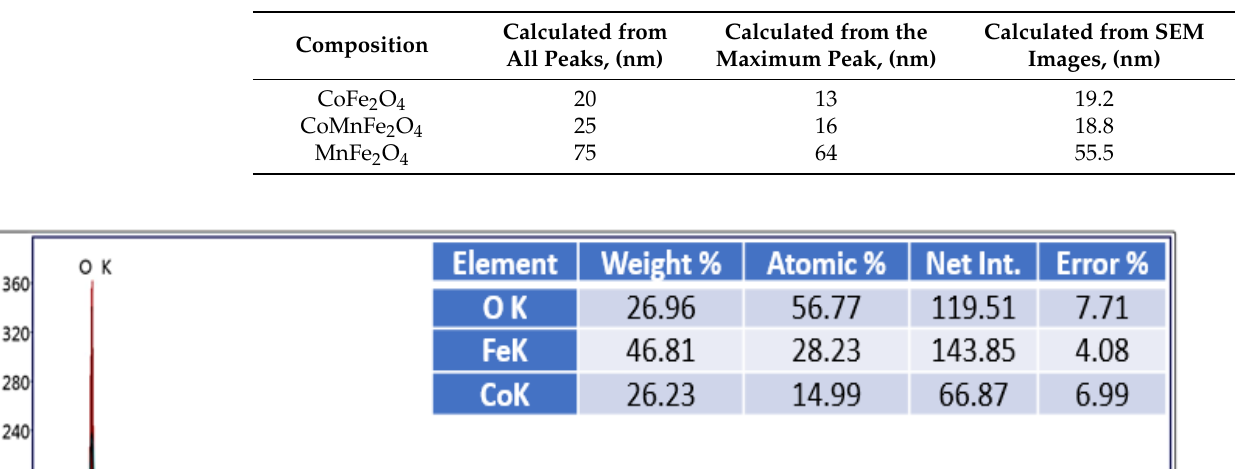
Figure 2. SEM images: Co-ferrite ( a ), Mn-ferrite ( b ), Co − Mn ferrite ( c ), Co-ferrite/graphene compo- site ( d ), Mn-ferrite/graphene composite ( e ), and Co − Mn ferrite/ graphene composite ( f ). Table 1. Average particle size calculated from the XRD patterns and SEM images.